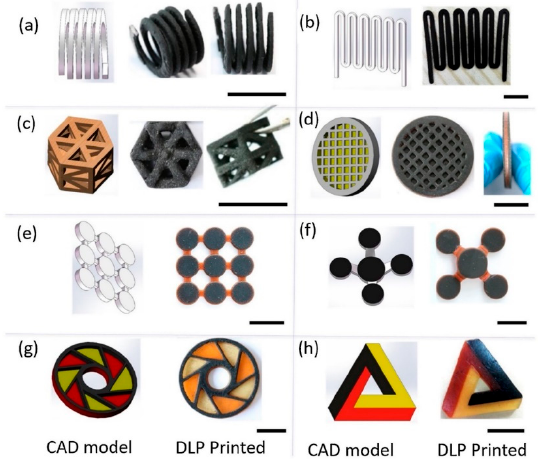
Figure 13. According to specified CAD models, various varieties of DLP 3D-printed conductive structures using MWCNT nanocomposite and immaculate resins. For printed items, the scale bar is 10 mm (adapted with permission from reference [40]).